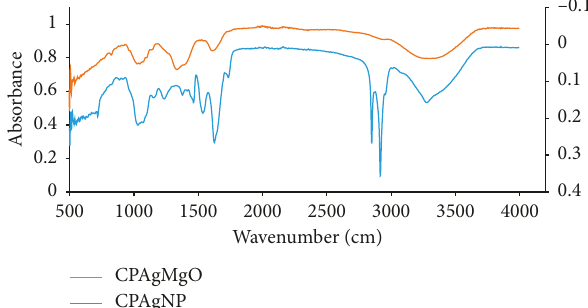
Figure 3: Comparative FTIR spectra of biosynthesized Ag and Ag-MgO